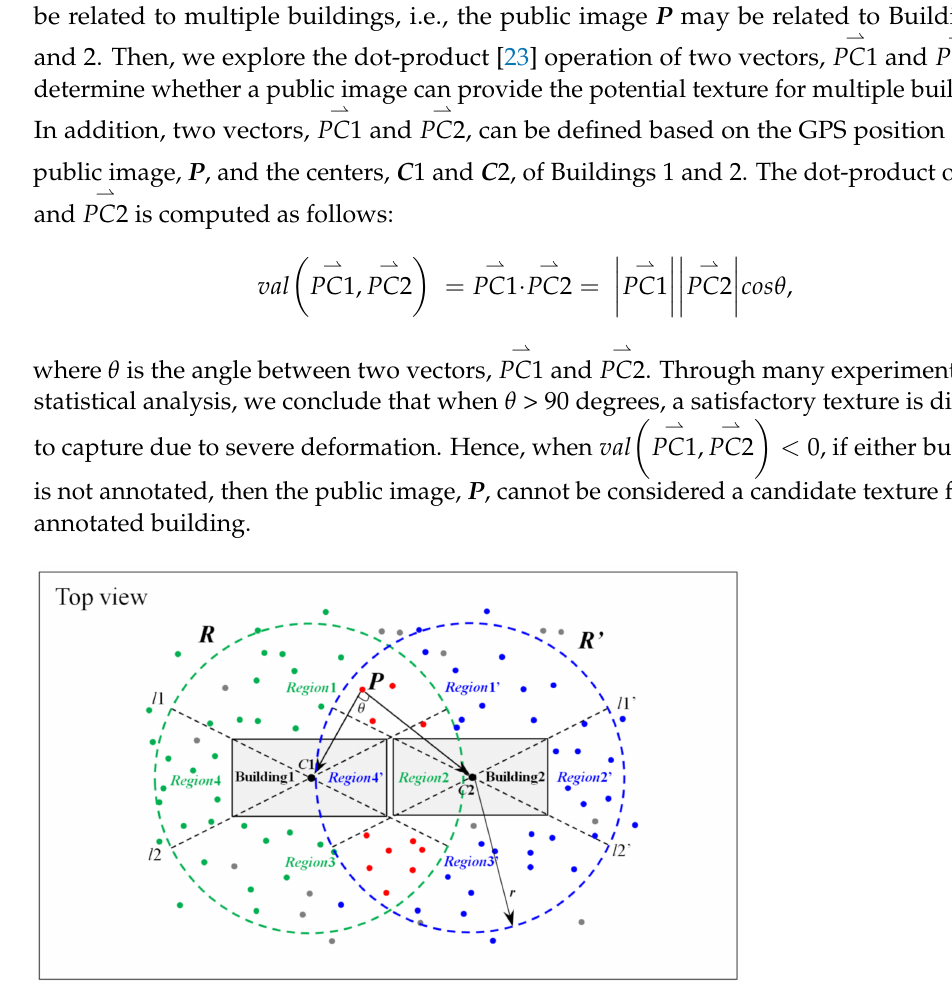
(cid:42) (cid:42) PC 1 and PC